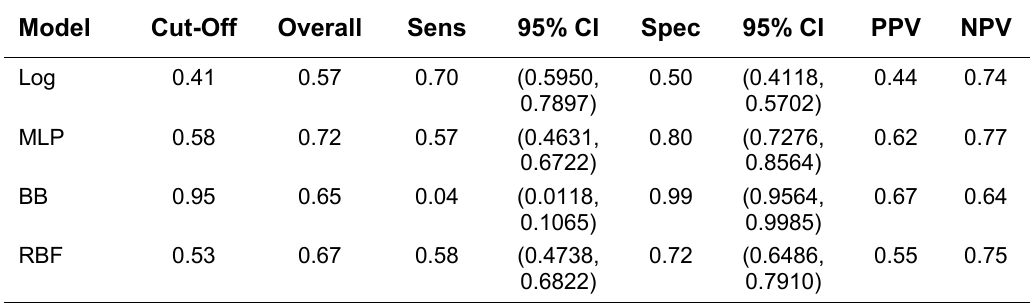
Model Performance Comparison of Sensitivity and Specificity Administrative and Clinical Data Testing Set — 365-Day